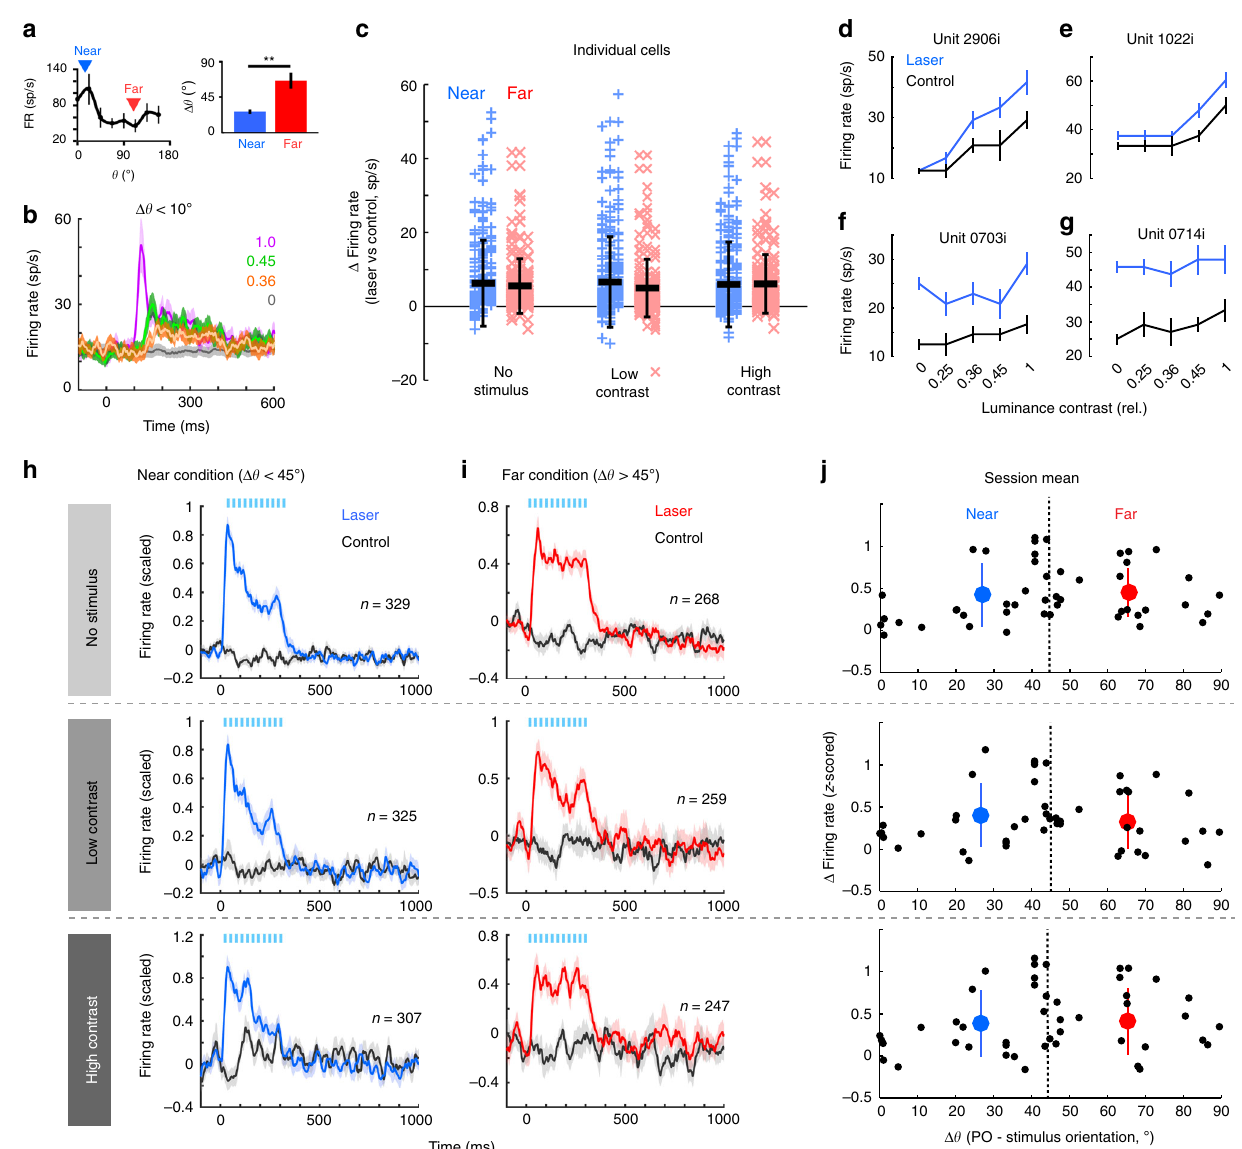
Fig. 3 Light-evoked activity is uniform across stimulus orientations and contrasts. a , left Example orientation tuning curve for one neuron. Arrowheads represent the orientation of the “ near ” (blue) and “ far ” (red) stimuli presented in that session. a , right Mean difference between the neural population preferred orientation and stimulus orientation for “ near ” (blue) and “ far ” (red) conditions. ** P = 2.8E-8, Wilcoxon rank sum test. Error shows s.e.m. b Mean fi ring rate of laser-responsive population on control trials, when the visual stimulus was within 10° of the preferred orientation of the neurons ( n = 21). Colored lines represent different contrasts. Error bars show s.e.m. c Firing rate change associated with laser for individual units in “ near ” (blue) and “ far ” (red) conditions ( fi rst 300 ms following light/stimulus onset). Thick horizontal bars represent the mean. Error bars represent the s.d. No group is signi fi cantly different from another ( P = 0.10, one-way ANOVA, df = 5, F-statistic = 1.86). d – g Contrast response functions for four example, light- responsive neurons ( fi ring rates from 60 – 300 ms after stimulus onset). Error shows s.e.m. h , i Population mean fi ring rate (±s.e.m.) for all laser-responsive units recorded in “ near ” ( h ) and “ far ” ( i ) conditions. Rows correspond to contrast conditions. j Mean fi ring rate change per session across contrast conditions (rows). Black circles represent the mean fi ring rate changes across all simultaneously recorded light-responsive cells. Dashed vertical line shows the cutoff between “ near ” and “ far ” conditions. Large colored circles represent the mean change in fi ring rate across all “ near ” (blue) and “ far ” (red) sessions. Error bars show the standard deviation. The differences in laser-evoked fi ring rates are not statistically signi fi cant across stimulus contrast conditions ( P = 0.35, Kruskal – Wallis